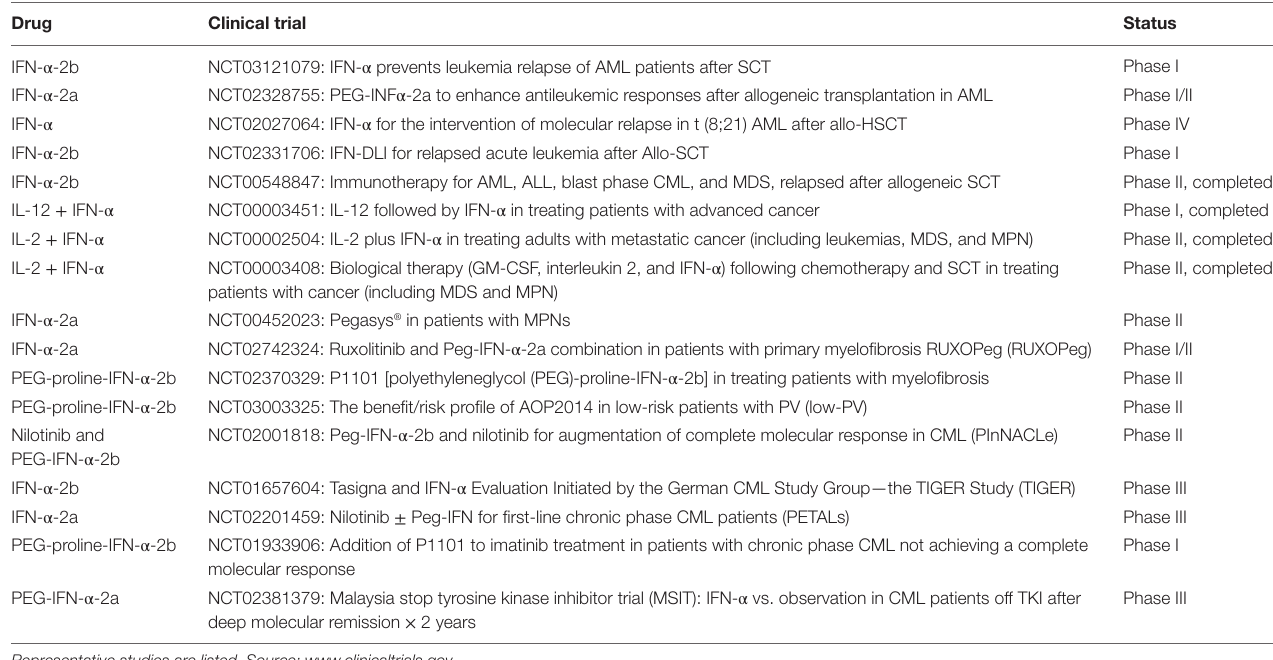
TABLe 1 | Clinical trials targeting interferon α / β MDS, MPN, and